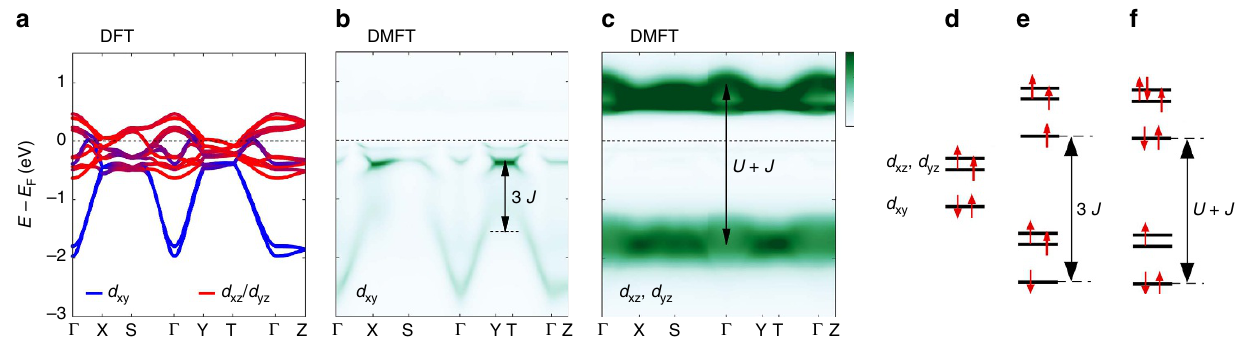
Figure 4 | Calculated orbital band character. ( a ) DFT calculation of the bare band structure. d xy and d xz , d yz characters are indicated by blue and red colours, respectively. ( b , c ) Are the spectral function calculated within the DMFTapproach and projected on the d xy and d xz , d yz orbitals, respectively. Dark colours correspond to high intensities. The indicated energy splittings stem from a t 2g multiplet analysis in the atomic limit. ( d ) Ground-state multiplet defined by the crystal field and Hund’s coupling J . ( e ) d xy electron removal configurations split by 3 J (see main text for explanation). ( f ) Representation of the twofold degenerate d xz , d yz electron addition and removal states, split by U þ